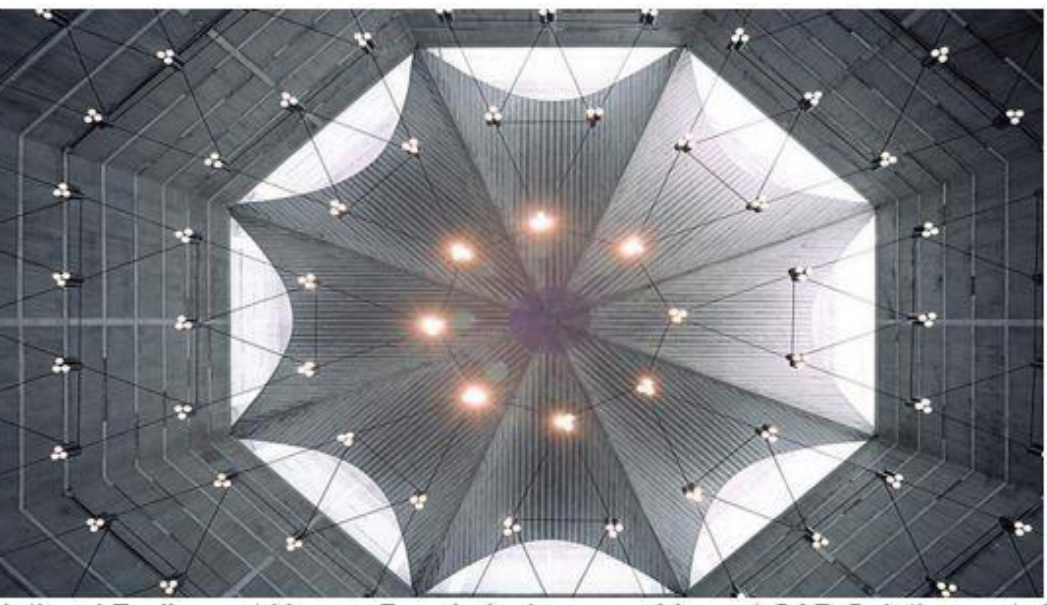
Figure 1. National Parliament House with roof light design [Source: www.rethinthinkingthefuture.com]